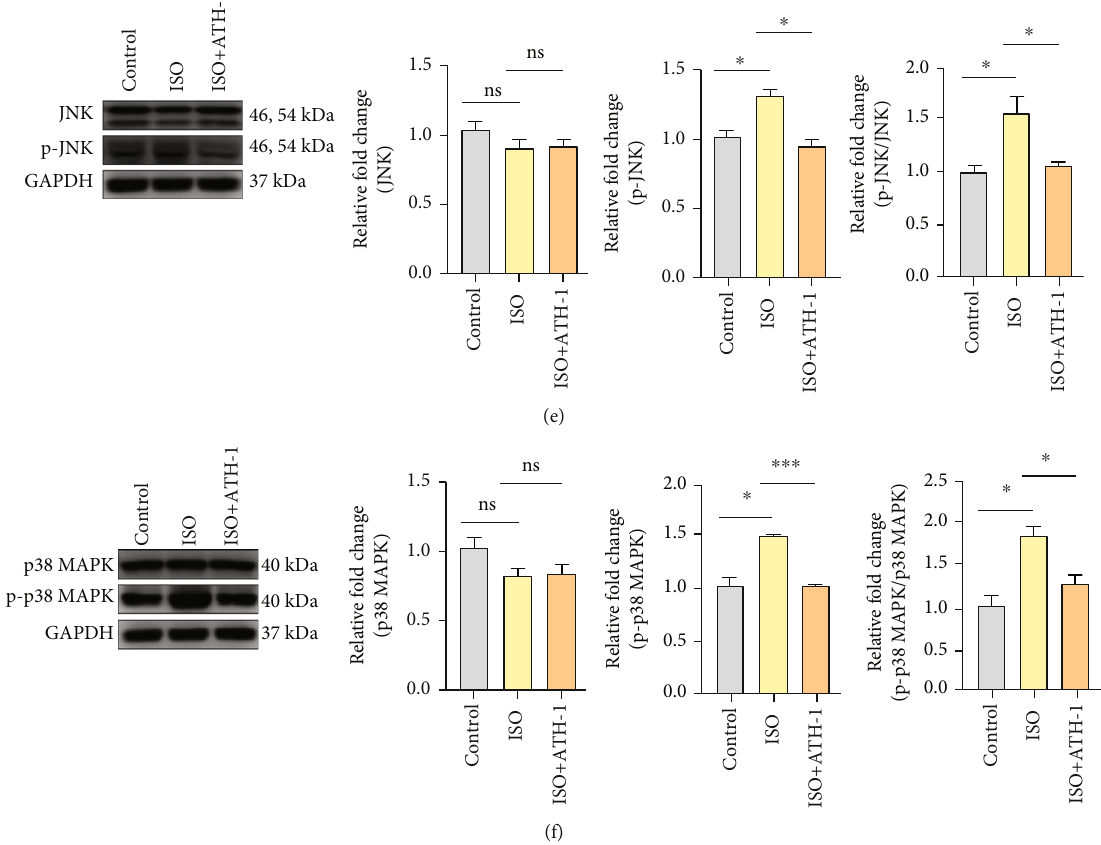
Figure 3: ATH-1 decreased the protein expression of Hspa1, p-ERK, p-JNK, and p-p38 in hypertrophic myocardium and enhanced the activity of T-SOD. (a) Di ff erentially abundant proteins identi fi ed in the iTRAQ experiment. (b) The protein expression of Hspa1 ( n = 3 ). ∗ P < 0 : 05 and ∗∗ P < 0 : 01 . (c) The activity of T-SOD in each group ( n = 3 ). ∗∗ P < 0 : 01 and ∗∗∗ P < 0 : 001 . (d) The protein expression of ERK1/2 and p-ERK1/2 ( n = 3 ). ns indicates none signi fi cance, ∗ P < 0 : 05 , ∗∗ P < 0 : 01 , and ∗∗∗ P < 0 : 001 . (e) The protein expression of JNK and p-JNK ( n = 3 ). ns indicates none signi fi cance, ∗ P < 0 : 05 . (f) The protein expression of p38 MAPK and p-p38 MAPK ( n = 3 ). ns indicates none signi fi cance, ∗ P < 0 : 05 and ∗∗∗ P < 0 : 001 . Table 1: DEPs with signi fi cant changed in both ISO vs. control and ATH-1 vs. ISO. ISO vs. control ATH-1 vs. ISO Accession Gene name Description P value P